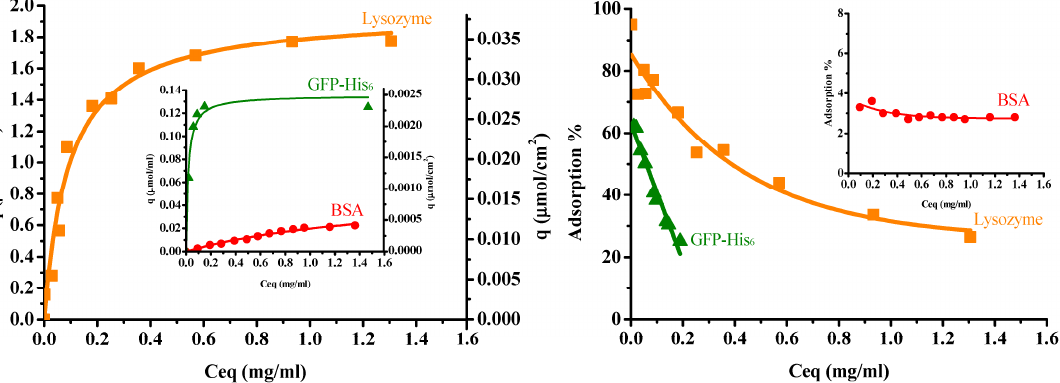
Figure 6. Protein adsorption isotherms ( left ) and adsorption percentages ( right ) for the prepared PAN-based IMAM at room temperature (pH 7 for lysozymes and BSA, pH 8 for GFP-His 6 ). As for the fitted values of the equilibrium dissociation constant K d , they were: 0.093 ± 0.014 mg/mL for lysozymes, 1.45 ± 0.41 mg/mL for BSA and 0.017 ± 0.004 mg/mL for GFP-His 6 . Since K d is the reciprocal of equilibrium association constant K a , it means the